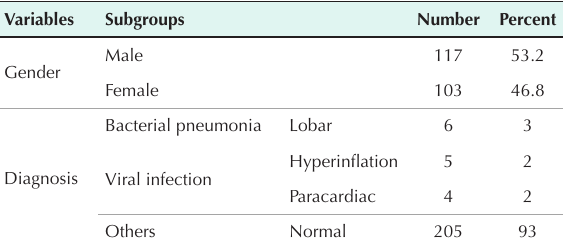
Table 1. Frequency of Gender, Diagnosis, and Types of Lung Radiographic Findings of the Participants Variables